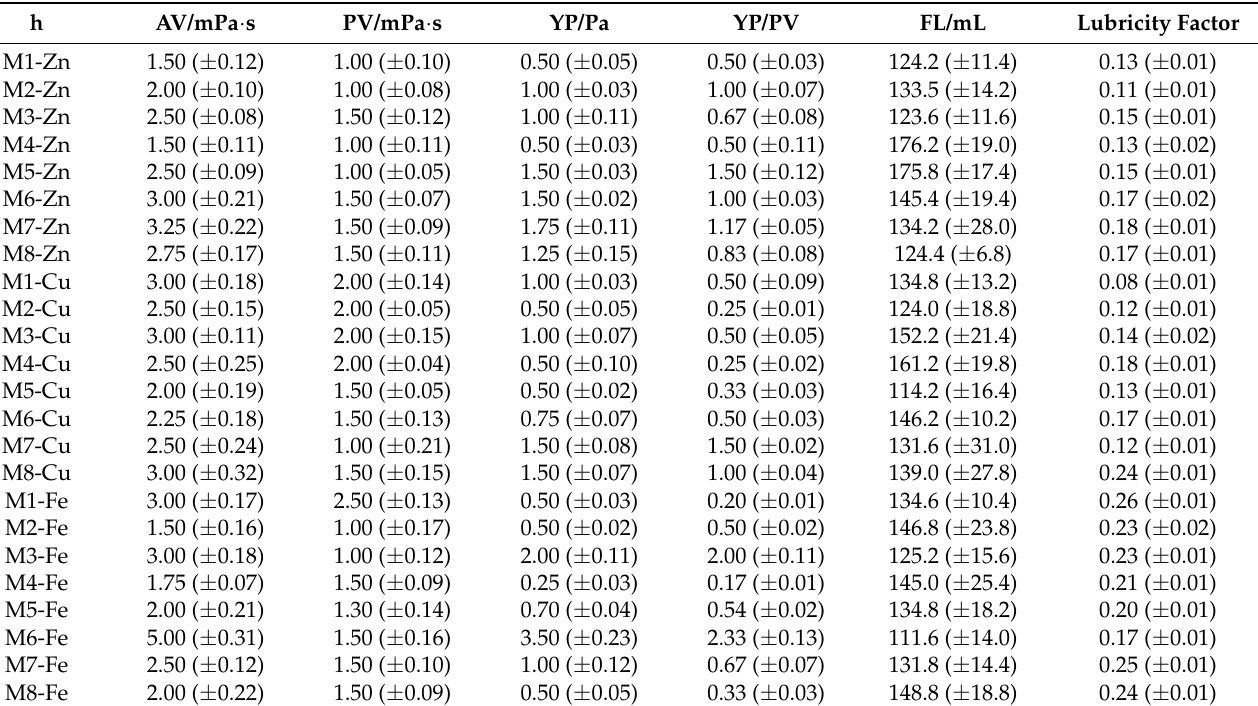
Table 4. Rheological properties of the 4% samples after 16 h of hot rolling at 200 ◦